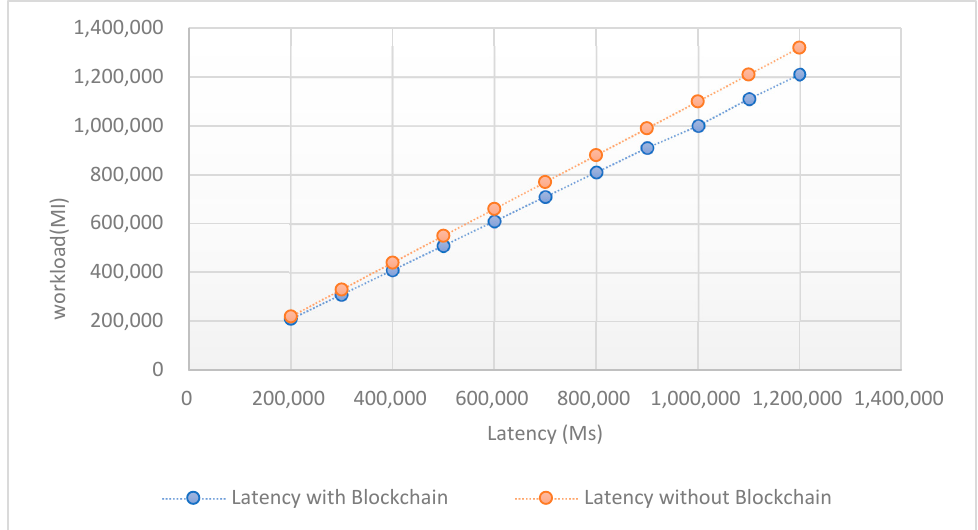
Figure 5. End-to-End Latency.